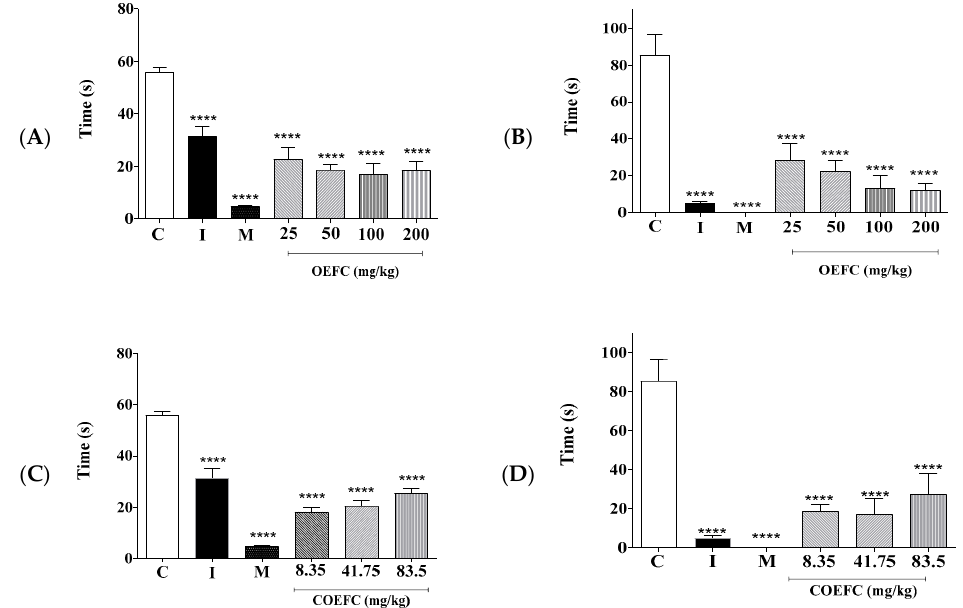
(Figure 4C). Indomethacin (10 mg/kg) and morphine (5 mg/kg), both administered sub- cutaneously, significantly reduced paw licking time by 43.57 and 91.34%, respectively (Figure 4A,C).